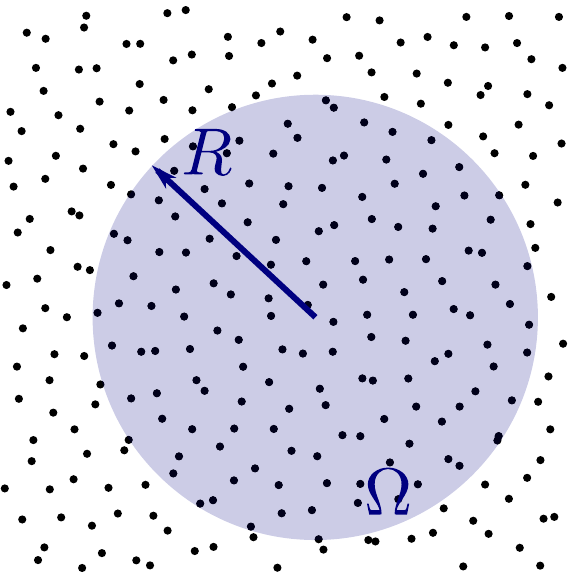
FIG. 1. Schematic showing a spherical window Ω of radius R used to sample fluctuations in the number of points in a two- dimensional point